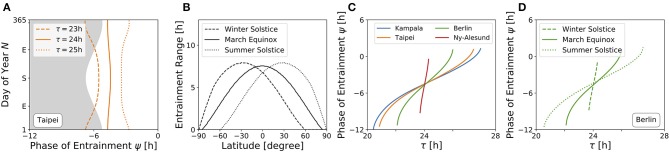
High sensitivity of phases during winter and at high latitudes. (A) Phase of entrainment ψ at the latitude of Taipei (ϕ = 25.03°) vs. time of the year (N) for three different internal free-running periods τ = 23 h (dashed line), τ = 24 h (bold line), and τ = 25 h (dotted line), respectively. The gray shaded area depicts the duration of darkness. (B) Entrainment ranges with respect to variations in τ as determined by the difference between the upper and lower limits of entrainment in Figures 5A–C for different latitudes, respectively. (C) Dependency of the phase of entrainment ψ on internal free running period τ on March equinox for the latitudes of Kampala (blue), Taipei (orange), Berlin (green), and Ny-Alesund (red). (D) Dependency of the phase of entrainment ψ on internal free running period τ at winter solstice (dashed line), March equinox (bold line), and summer solstice (dotted line) at the latitude of Berlin (ϕ = 52.51°). All simulations have been performed for light perceived by a horizontal plane. Phases of ψ = ±12 h and ψ = 0 h correspond to midnight and solar noon, respectively.